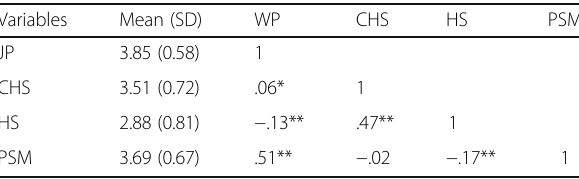
Table 5 Intercorrelations between challenge stress (CHS), hindrance stress (HS), public service motivation (PSM), and job performance (JP)